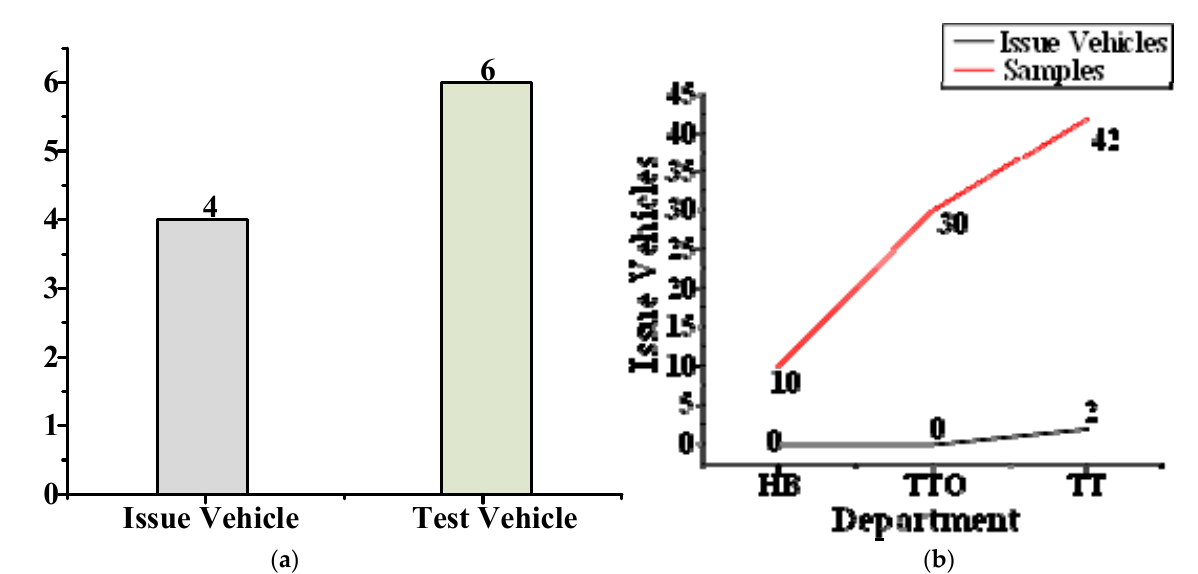
Figure 1. Vehicle survey map. ( a ) Statistical chart of problem vehicles; ( b ) number of problem vehicles by department. HB is Hard Tooled Functional Build. TTO is Tool Try-Out. TT is Tooling Trial. HB, TTO and TT are the three departments in automobile production.